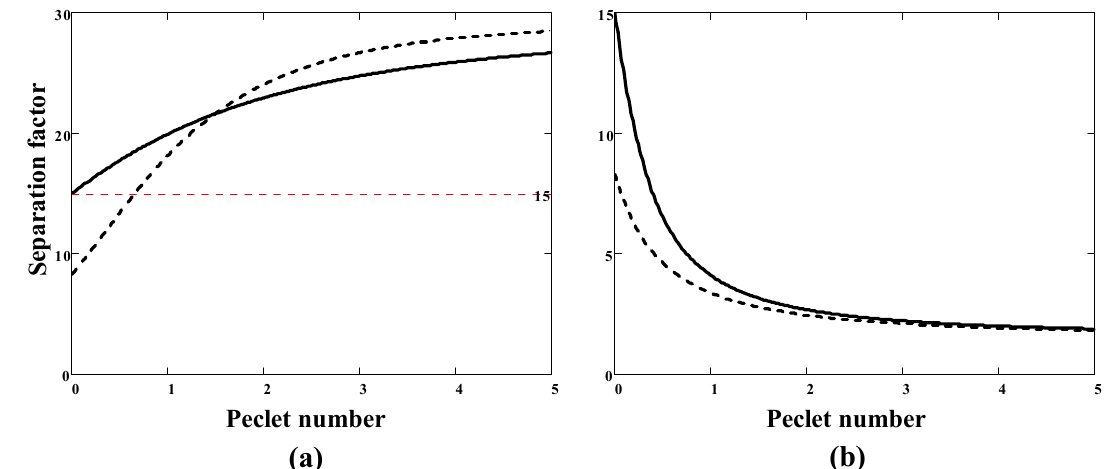
Figure 1. Separation factor for the binary gas mixture (molar fraction x 1 = 0.1) with the ideal selectivity α 12 = 15 as a function of the membrane Peclét number: ( a ) sorption-selective membrane ( α S = 30, α D = 0.5); ( b ) diffusion-selective membrane ( α S = 1.5, α D = 10). Solid lines: the pressure ratio r = 0, dotted lines: r = 0.1.